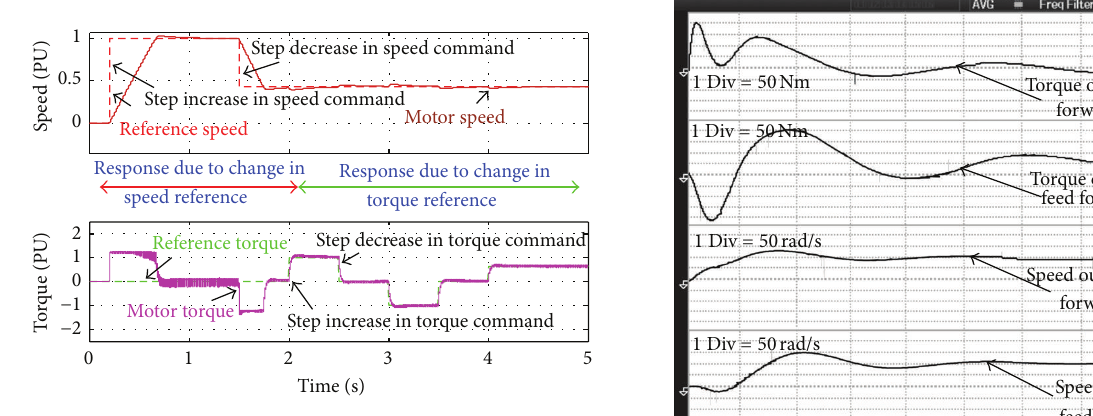
Figure 14: Speed, torque response of DTC method.